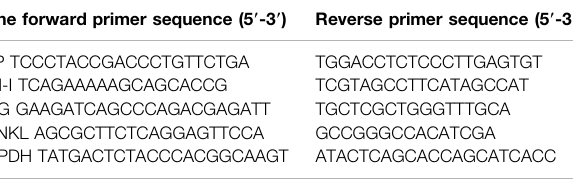
TABLE 1 | Primers used for qRT-PCR.